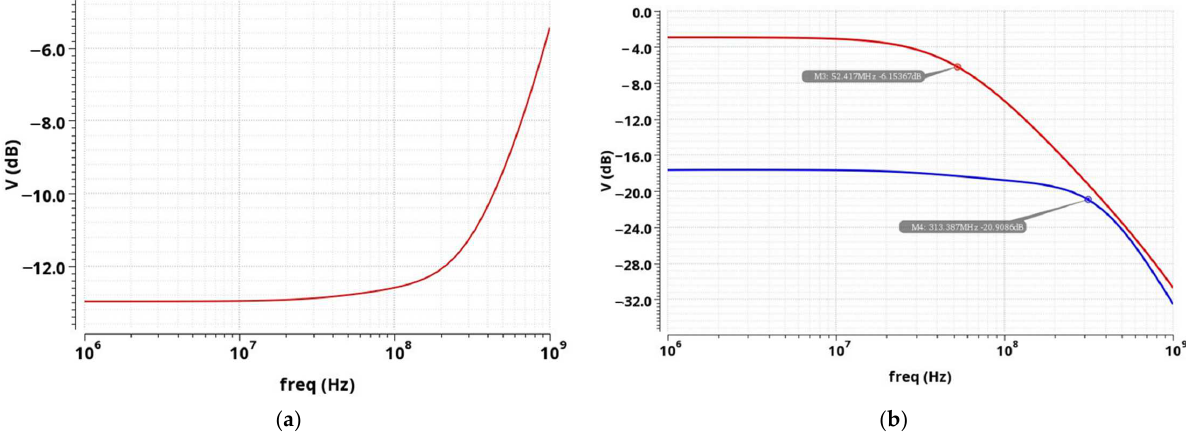
Figure 13. ( a ) Frequency response of passive equalizer; ( b ) −3 dB bandwidth extension of transmitter using passive equalizer.